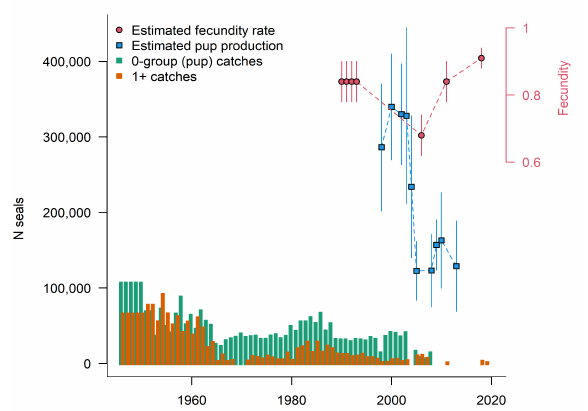
Figure 1. All available input data for the Barents Sea/White Sea harp seal population. Reproduction (number of seal pups born in year y) is given by: